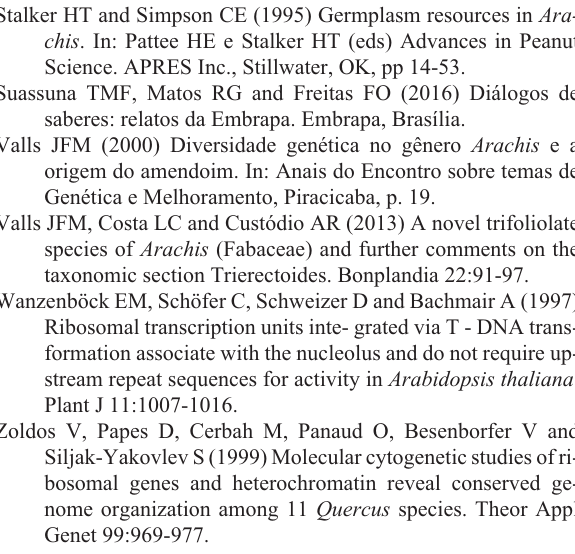
FigTree software v.1.4.4, http://tree.bio.ed.ac.uk/software/figtree/